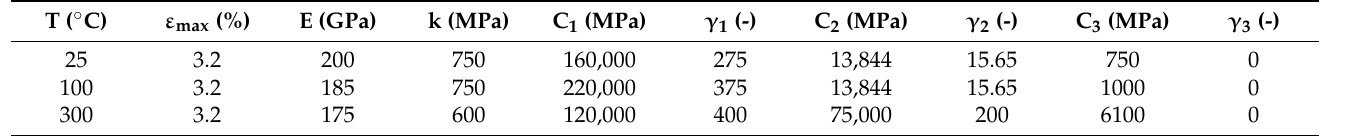
Table 2. Determined Chaboche parameters for 42CrMo4 + QT (47 HRC)/AISI